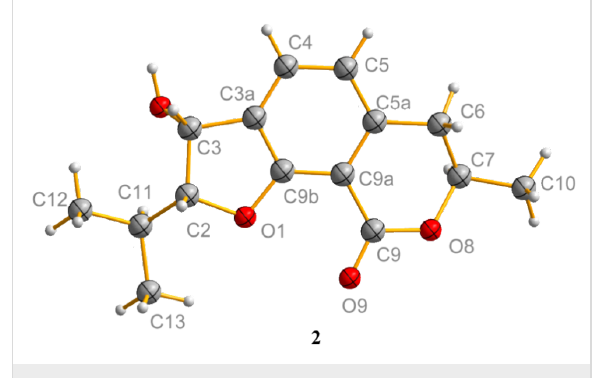
Figure 3: ORTEP structure of compound 2 .